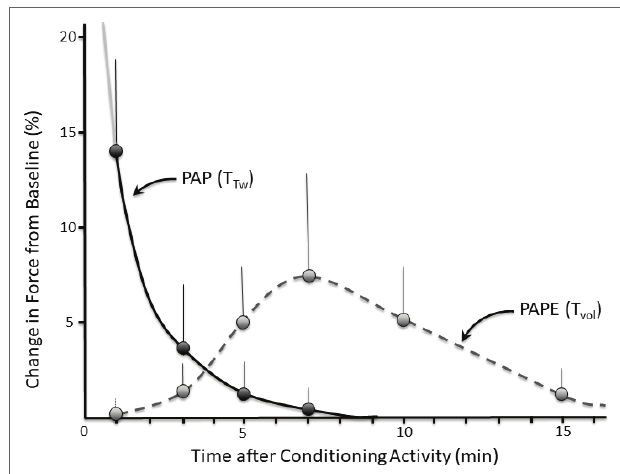
FIGURE 2 | Time course (with example error bars) of post-activation potentiation (PAP) measured as the torque evoked during a twitch contraction (T Tw ) versus post-activation performance enhancement (PAPE) measured as the torque produced during a voluntary contraction (T Vol ). PAP and PAPE exhibit different temporal profiles, suggesting that they are at least partly different phenomena. Data for illustrative purposes only; experimental data can be seen in Seitz et al. (2015); gray solid line indicates that PAP would be higher at time points < 1 min (>80% according to Hamada et al., 2000). Note: functions are plotted from 1 min because the first experimental data were collected at this time